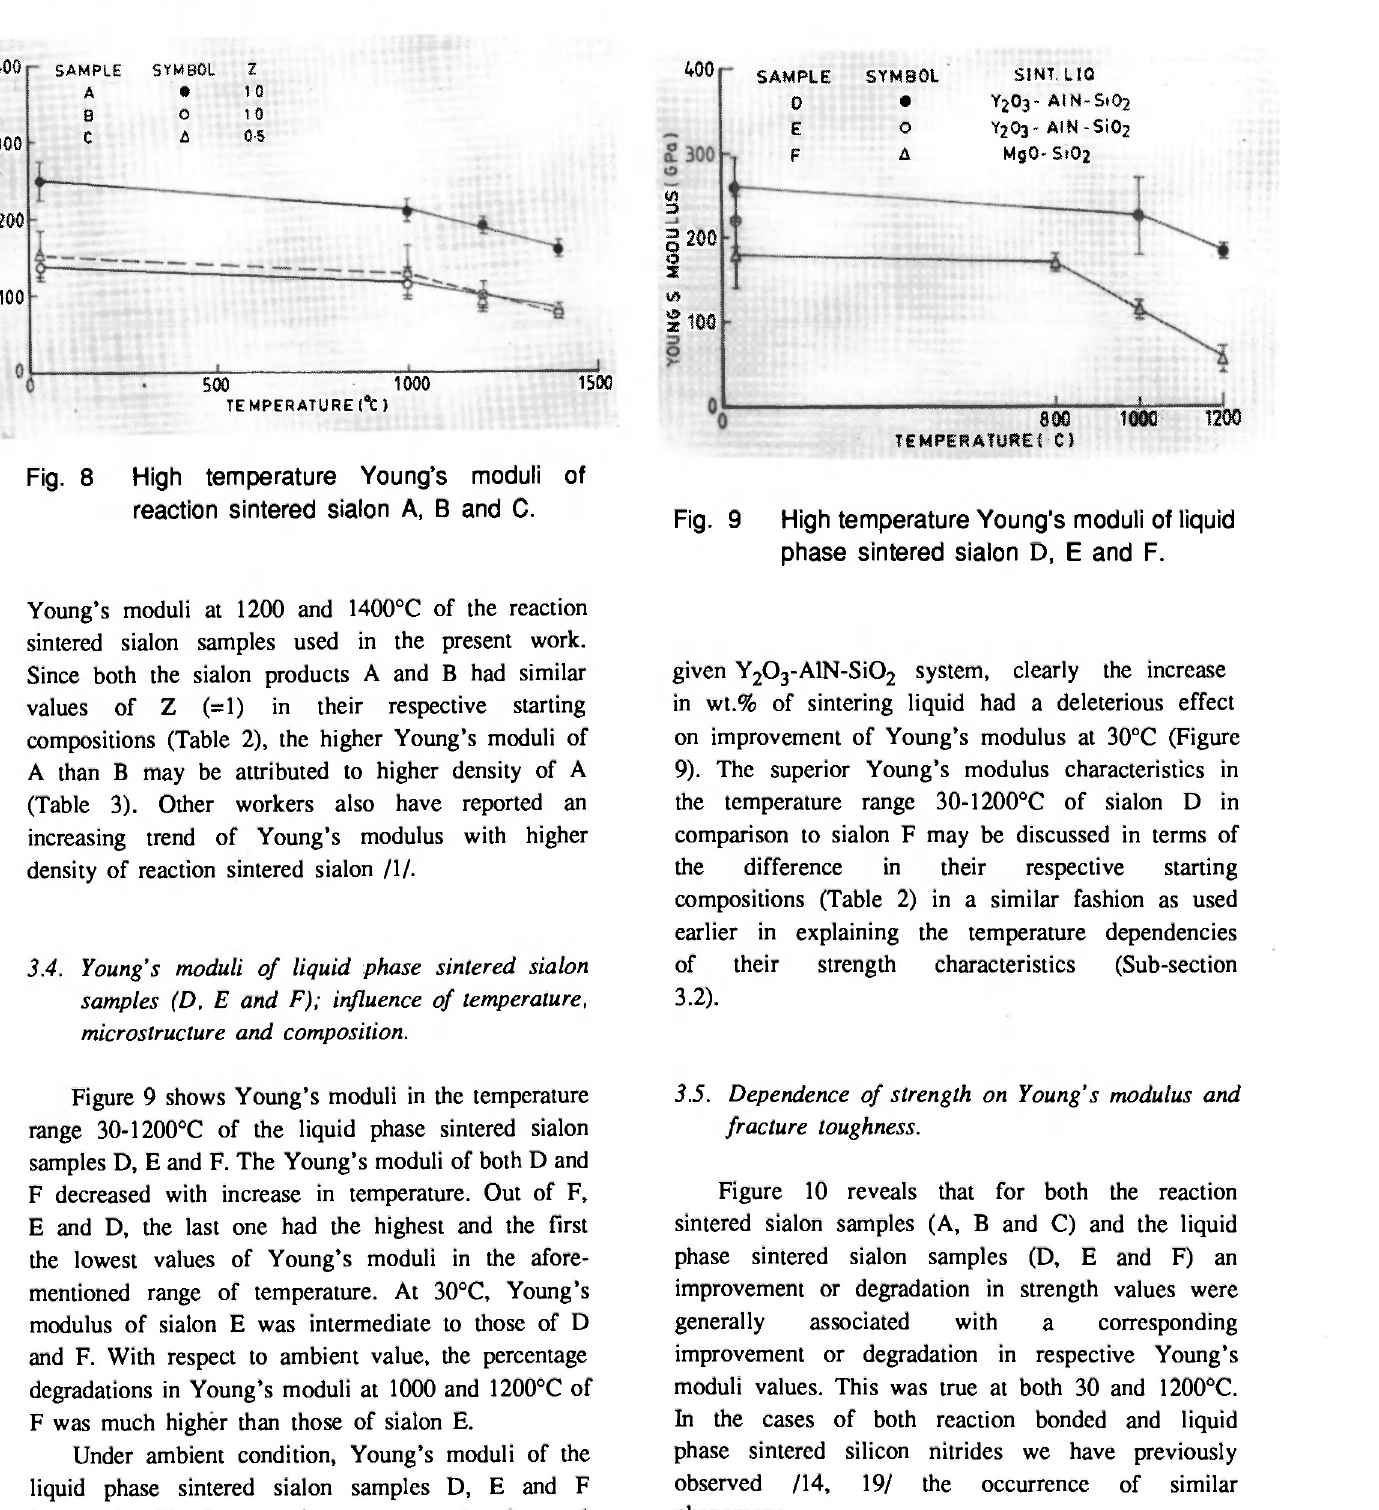
500 1 000 1500 TEMPERATURE it) High temperature Young's moduli of Fig. 8 reaction sintered sialon A, Β and C. High temperature Young's moduli of liquid